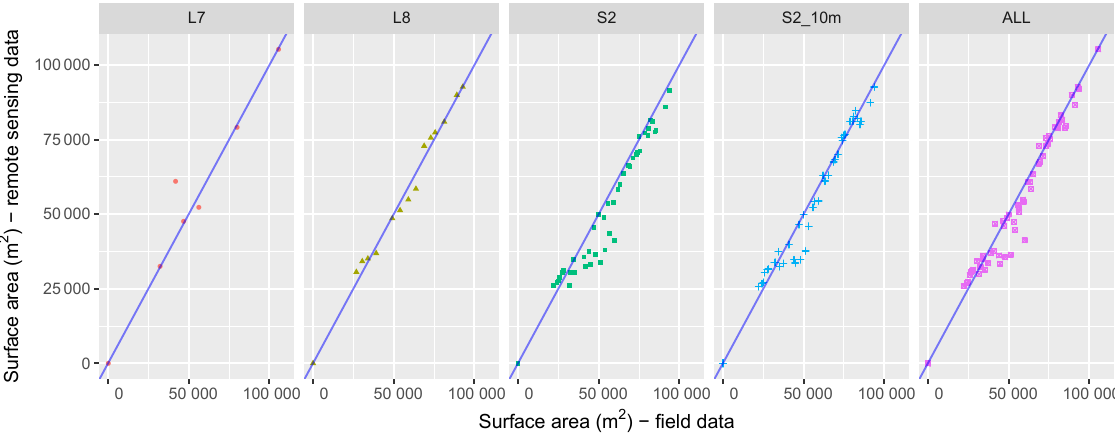
Figure 22. Remotely sensed surface areas with Sentinel-2 and Landsat 7 and 8 data vs. field data over 2016–2017 on Lake Gouazine.